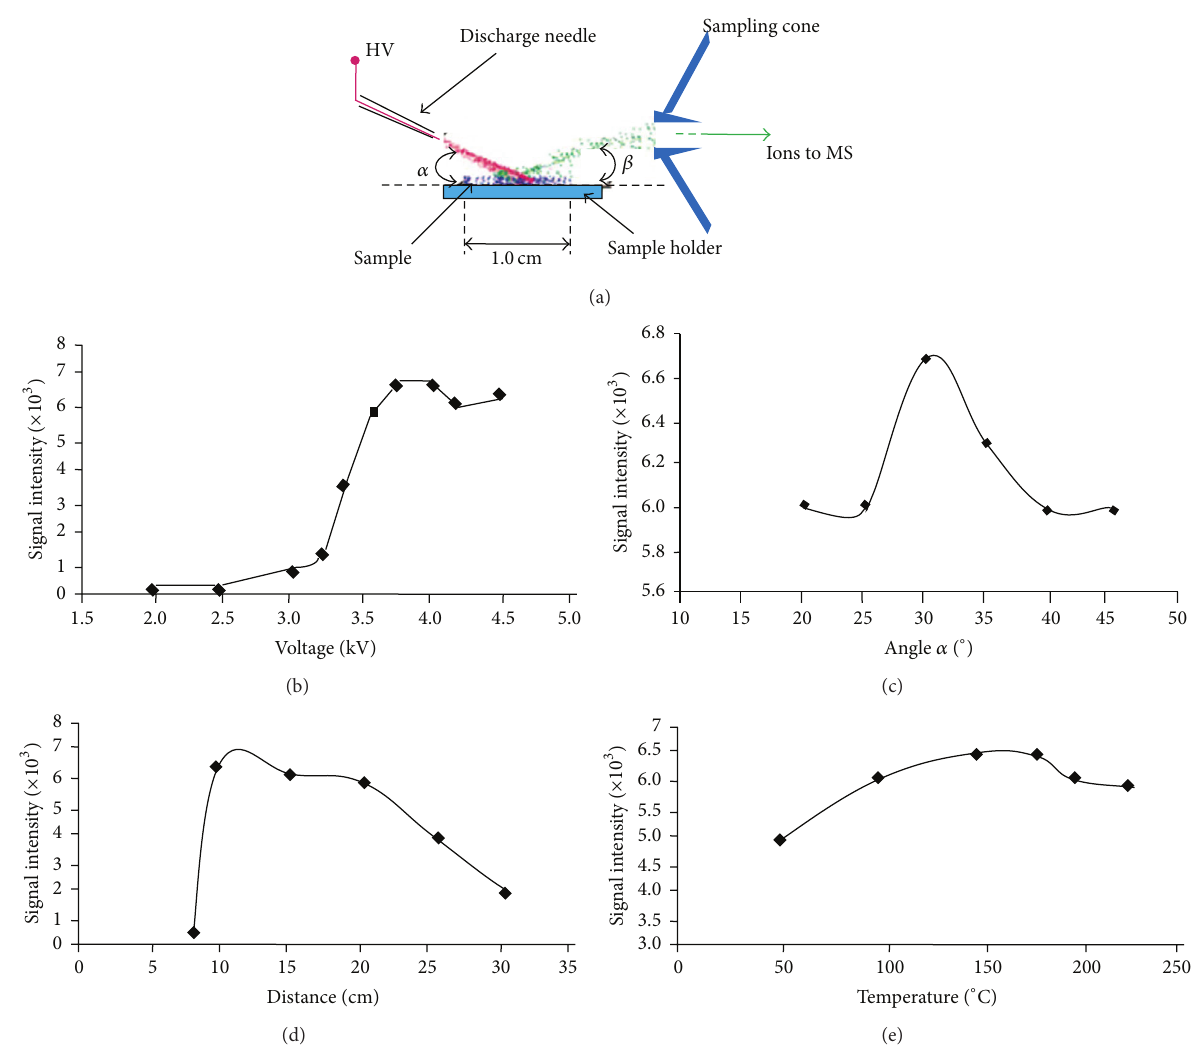
Figure 1: Schematic diagram of SDAPCI source and optimization of SDAPCI source conditions. (a) Schematic diagram of SDAPCI source for measurement of propolis. (b)–(e) Optimization of SDAPCI source conditions including the effect of discharge voltage on signal intensity (b), the effect of the angles 𝛼 (c), the effect of the distance between the discharge tip and the ion entrance (d), and the effect of the temperature of the heated capillary (e). All the optimization experiments were based on the signal intensity of the peak signal at 121 m/z for sample 1 (HLJ). Each point represents an average of six